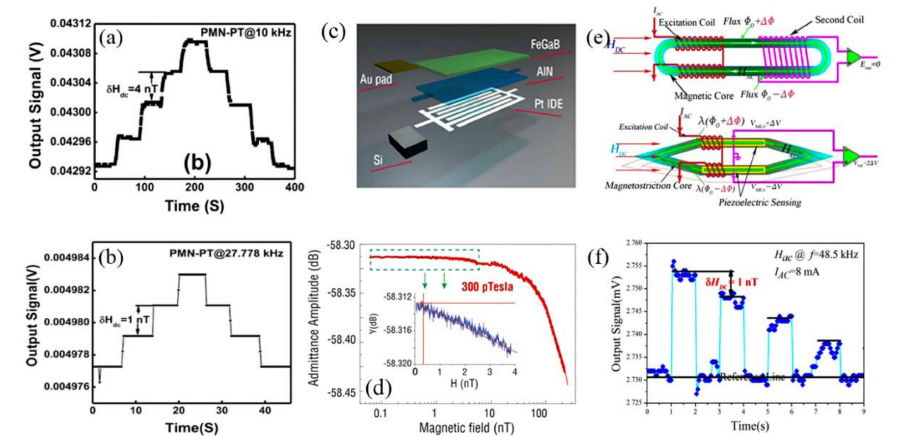
Figure 7. The measurement of LoD for Metglas/PMN–PT ME laminate at ( a ) f = 10 kHz and ( b ) resonance frequency of 27.778 kHz [31]. ( c ) Schematic representation and ( d ) the measurement of LoD for NMES AlN/(FeGaB/Al 2 O 3 ) multilayered heterostructure [51]; ( e ) Schematic representation of the conventional flux gate senor and the proposed ME flux gate sensor [64]; ( f ) The measured results for DC magnetic field resolution